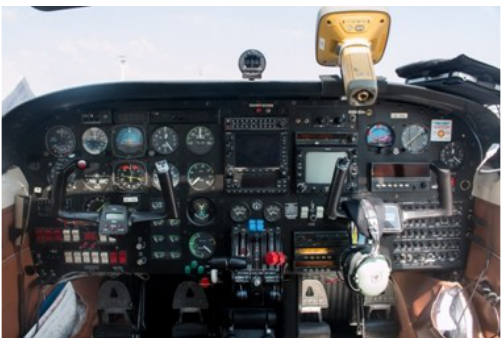
Figure 6. GNSS receiver mounted on the